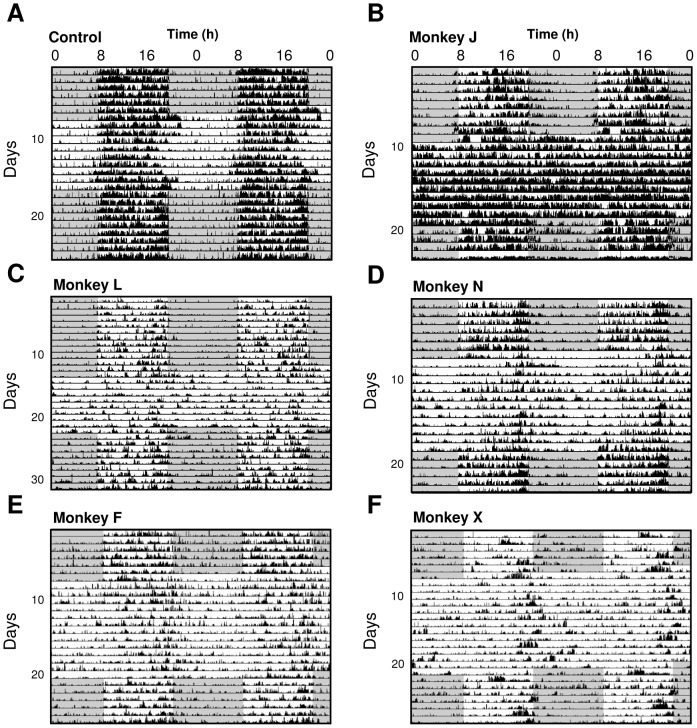
Double-plotted actograms illustrating alteration of circadian expression of locomotor activity in constant light (LL) in an untreated control and in 5 MPTP treated animals in addition to that shown in Figure 1.Note that while daily locomotor rest activity rhythms are observed for all animals during the LD cycle preceding and subsequent to LL. In MPTP-treated animals the circadian rhythm of locomotor activity was strongly altered (D, E, F) or abolished (B, C) in LL. C and F were highly symptomatic cases, D and E were mildly symptomatic and B was asymptomatic. The dark phase is shown by shaded areas and light phase by light areas.